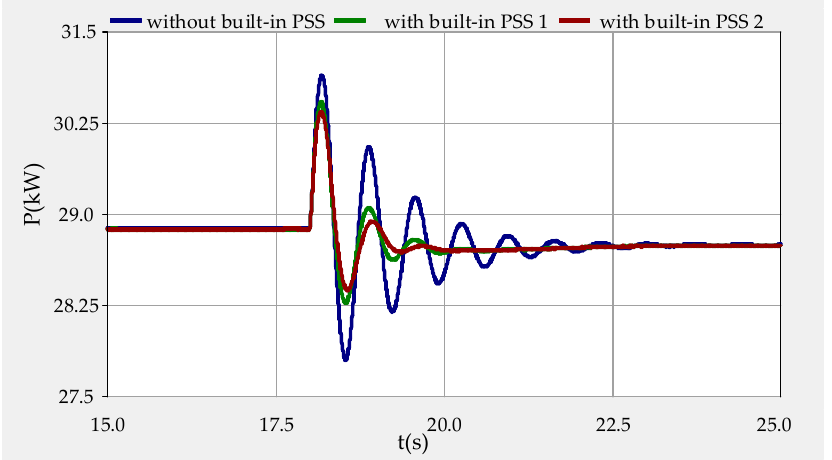
Figure 13. Active power waveform of the generator under the system with and without built-in PSS.